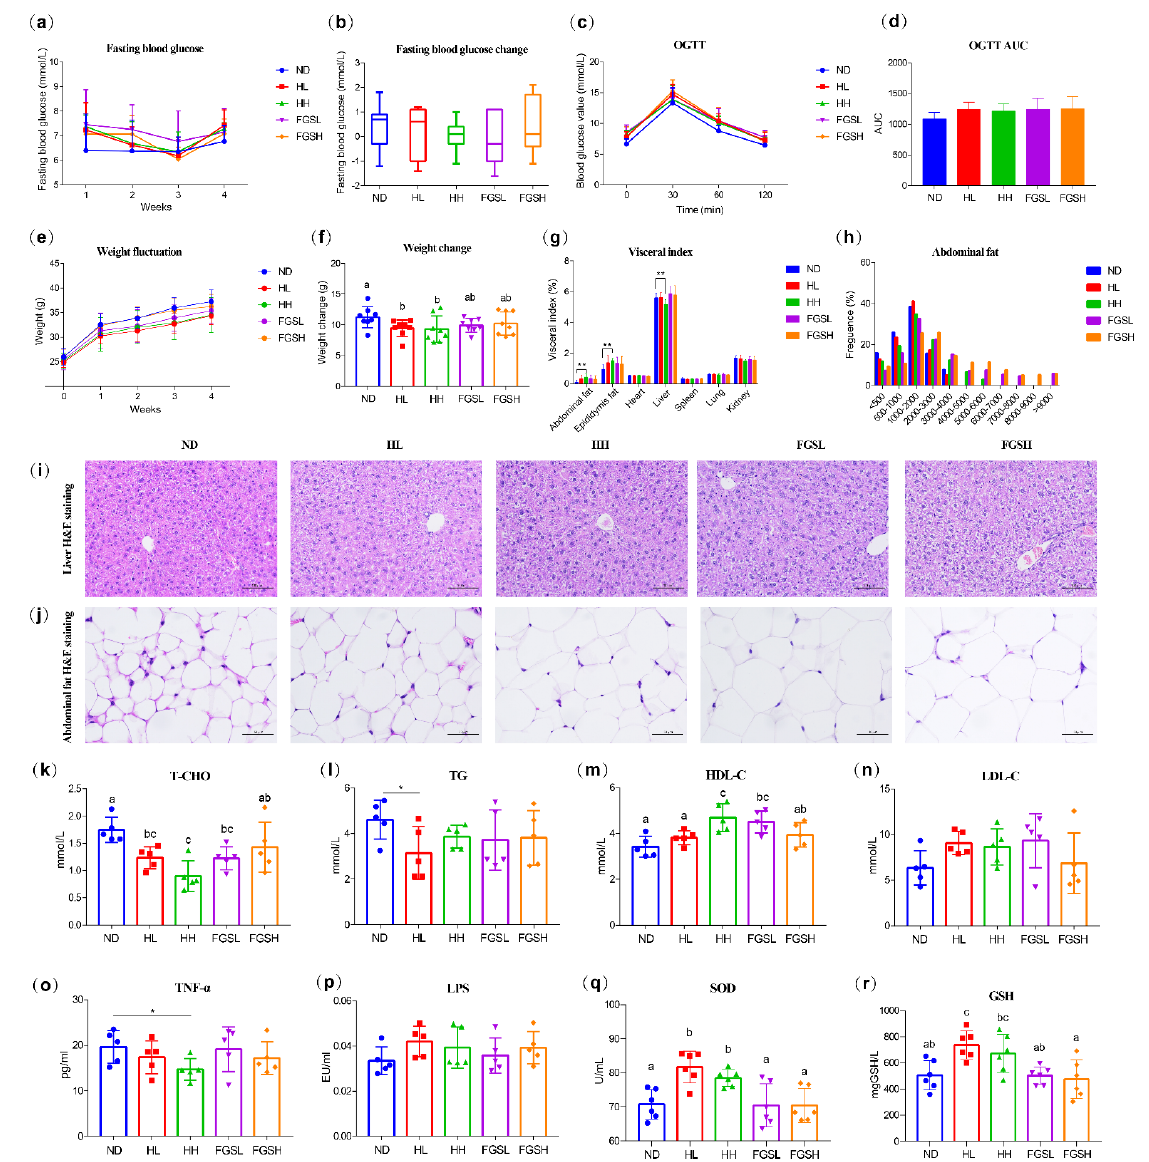
Figure 2. Effects of honey and mixed-sugar feeding on glucose homeostasis, body weight, liver and abdominal fat accumulation, visceral index, serum lipid and inflammatory factors, and oxidative stress levels. Fasting blood glucose levels ( a ) and their change values ( b ) were measured weekly over four weeks. Results of the OGTT ( c ) and its AUC ( d ) were detected after a long gavage period. Body weight fluctuation ( e ) and change ( f ) were measured weekly for four weeks. Visceral index ( g ) was detected after a long feeding period. Liver ( i ) and abdominal fat ( j ) cell morphology were assessed using hematoxylin and eosin staining. Abdominal adipocyte size ( h ) was evaluated by ImageJ software. Scale bar, 50 µ m. Lipid concentrations are presented of T-CHO ( k ), TGs ( l ), HDL-C ( m ), and LDL-C ( n ). Cytokine concentrations are presented of TNF- α ( o ) and LPS ( p ). Serum oxidative stress levels were analyzed in terms of the enzyme activity—SOD ( q ) and GSH ( r ). Data are expressed as the mean ± SD. Graph bars ( f , k , m , q , r ) with different letters on top correspond to statistically significant results ( p < 0.05) based on a one-way ANOVA. In contrast, bars with the same letter correspond to results that showed no statistically significant difference. Differences in the graph bars ( g , l , o ) were analyzed using one-way ANOVA (* p < 0.05, ** p <